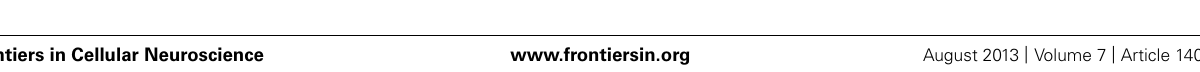
Frontiers in Cellular